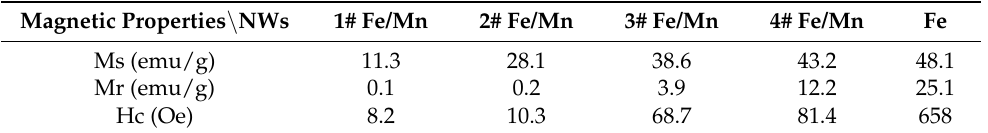
Figure 6. Typical hysteresis loops of NWs at 300K: ( a ) Fe/Mn@SiO 2 multilayer NWs; ( b ) Fe@SiO 2 NWs. Table 4. Magnetic properties of Table 4. Magnetic properties of NWs.